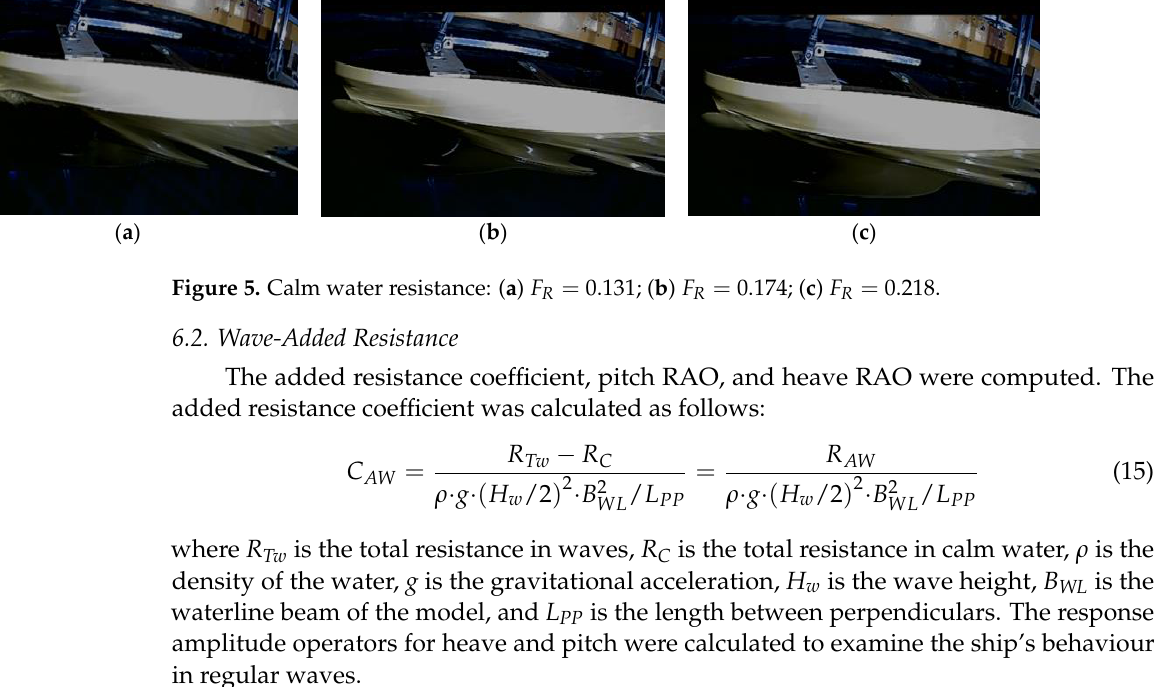
Figure 4. Resistance test.